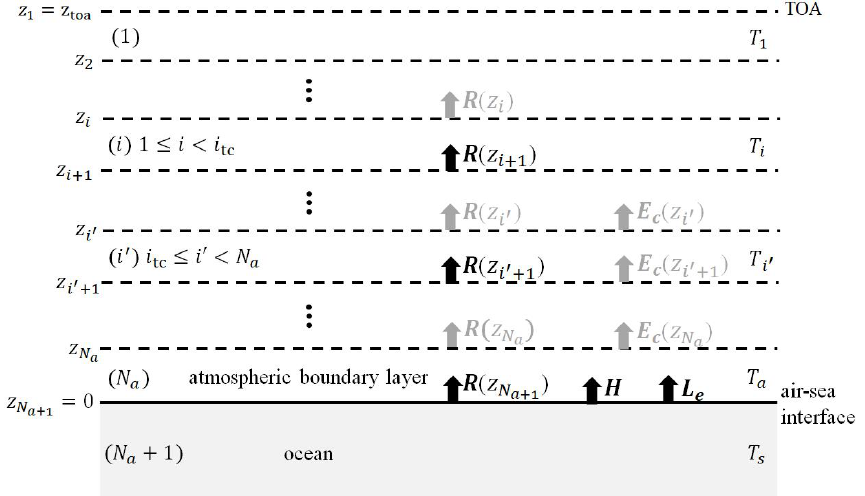
Figure A2. Vertical profile of atmosphere coupling with ocean. The energy exchanges without convection in atmospheric layer ( i ) , with 1 ≤ i < i tc , where layer ( i tc ) is the topmost layer that involves convection. Black arrows and gray arrows indicate inflow energy and outflow energy, respectively, across layer